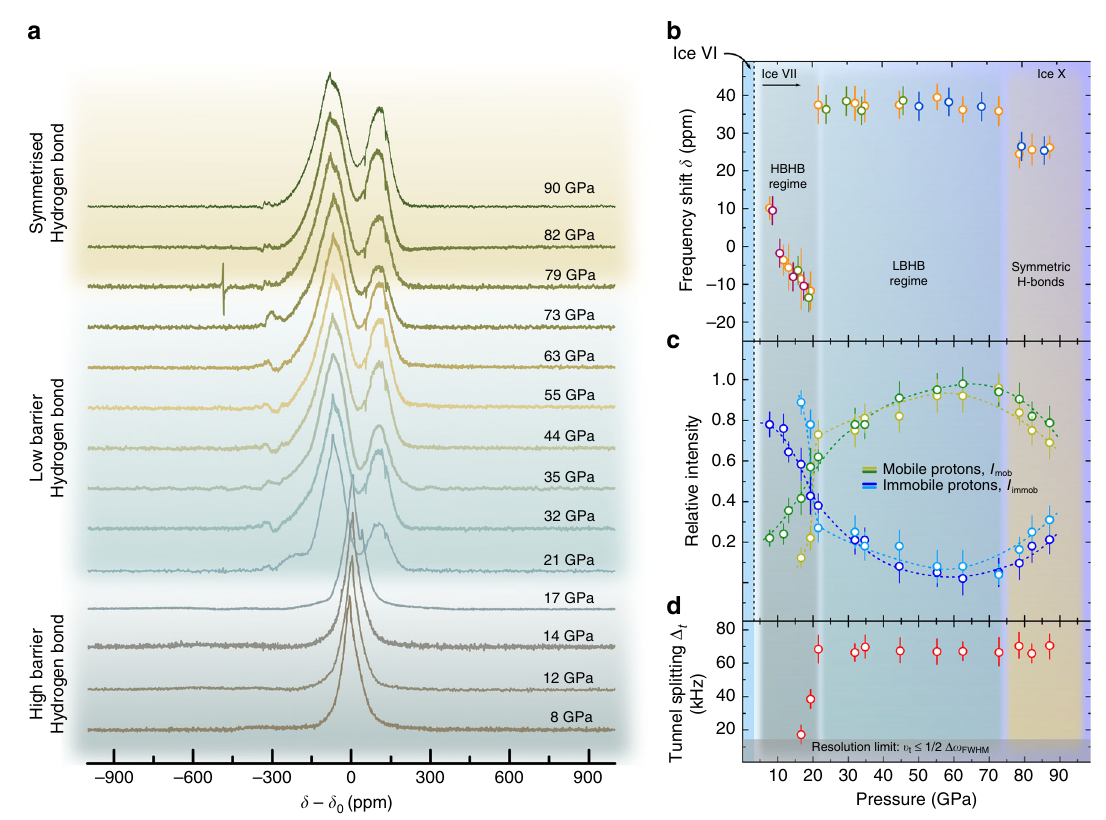
Fig. 3 Summary of high- fi eld data collected at 9.3 T. a Proton NMR signals of ice from 8 to 90 GPa. b chemical shifts relative to a water sample at ambient conditions. c Intensities from localized and tunneling protons. d tunnel splittings up to 90